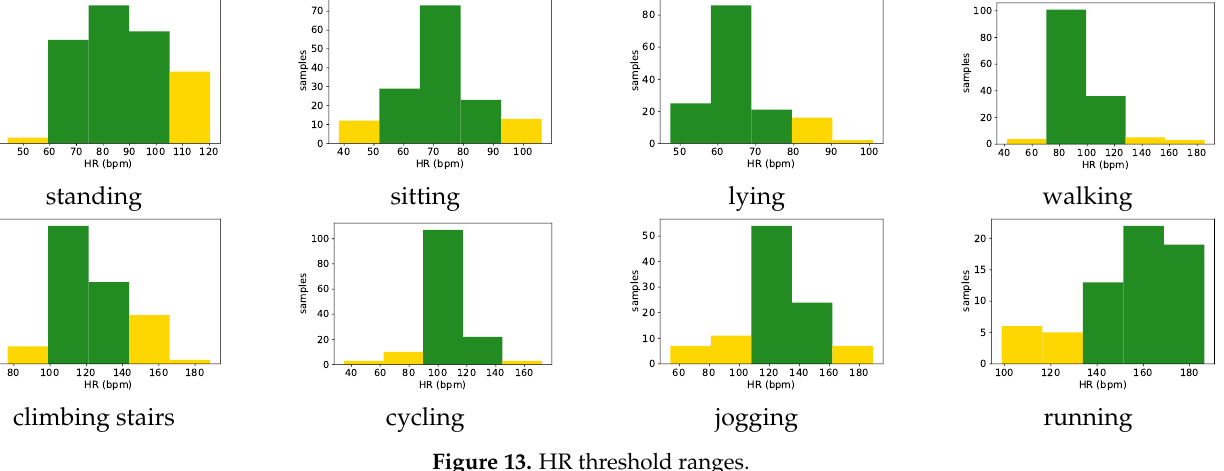
Figure 13. HR threshold ranges.